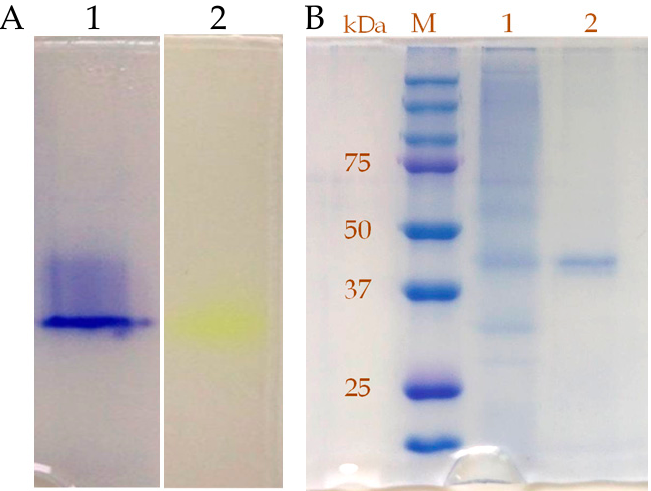
Figure 4. Polyacrylamde gel electrophoresis of the β -glucosidase purified from T. fusca NTU22. ( A ) Native polyacrylamide gel electrophoresis (PAGE) of the purified enzyme. Lane 1: Protein stained by Coomassie Brilliant Blue R-250. Lane 2: Activity stained by p -nitrophenyl- β -glucopyranoside. ( B ) SDS-PAGE. Lane M: Protein molecular mass standard; Lane 1: Crude culture filtrate; Lane 2: Purified β -glucosidase. Electrophoresis conditions: 150 V, 1